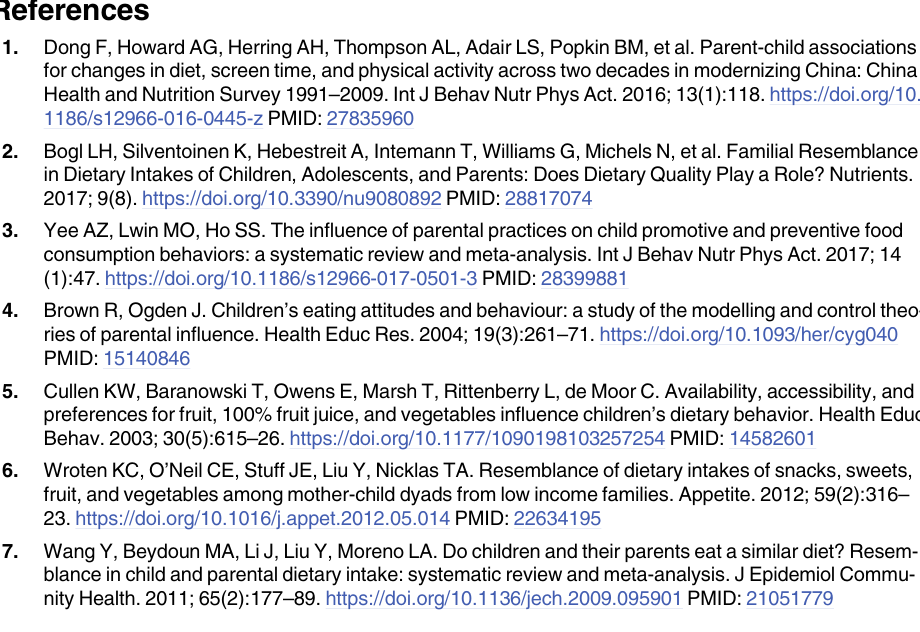
S1 Table. Linear regression model for predicting offspring dietary intakes by differences in living arrangements. S2 Table. Linear regression model for predicting grandson/daughter dietary